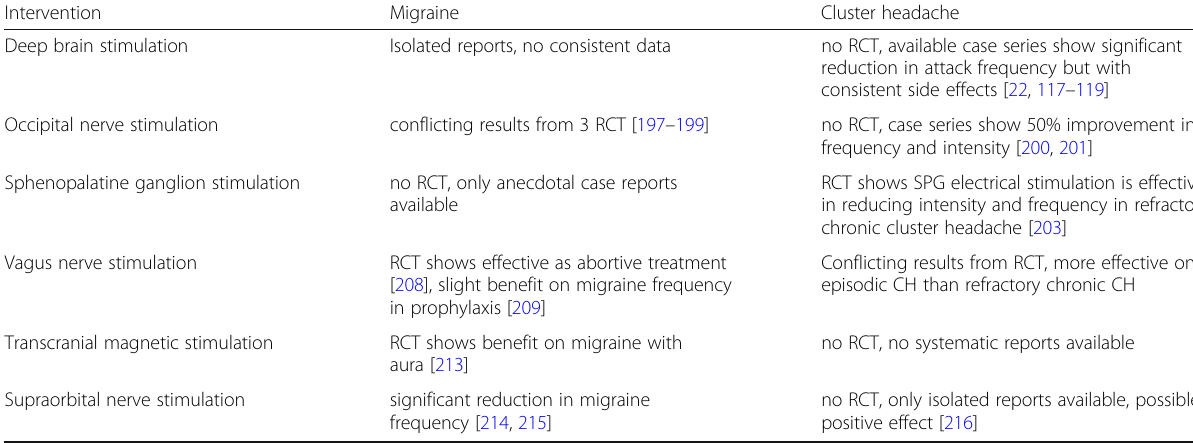
Table 6 Efficacy of neuromodulation strategies in migraine and cluster headache Intervention Migraine Cluster headache Deep brain